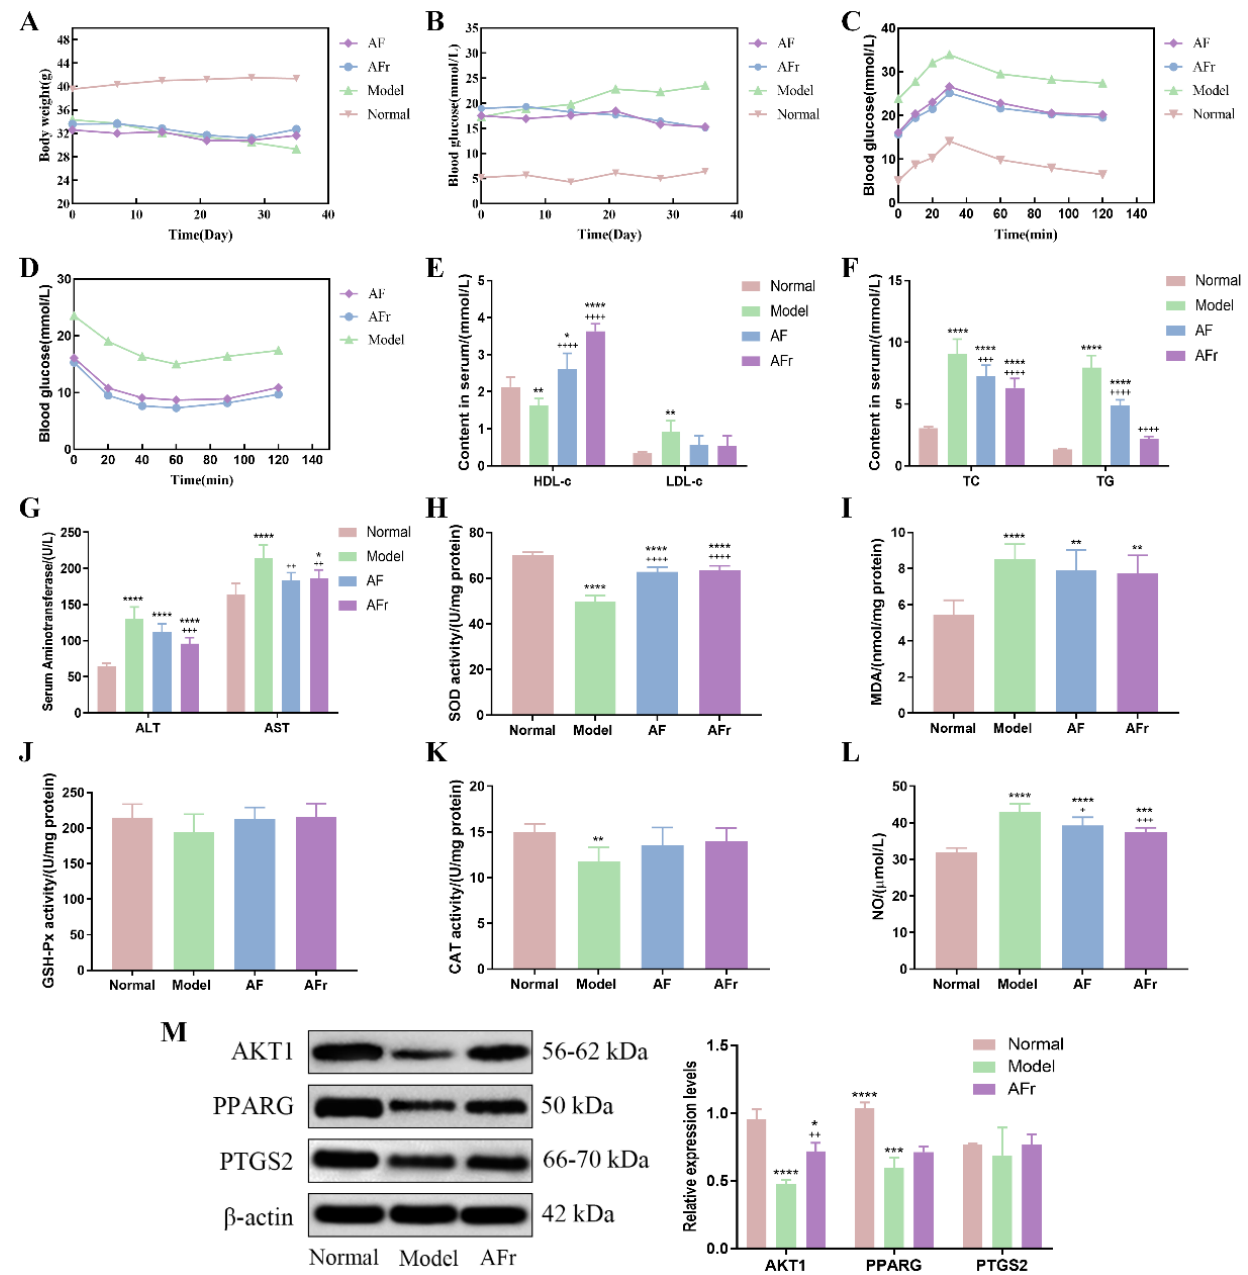
Figure 6. Effects on body weight ( A ), fasting blood glucose (FBG, B ), oral glucose tolerance test (OGTT, C ), insulin tolerance test (ITT, D ), high/low − density lipoprotein cholesterol (HDL − c & LDL − c, E ), total cholesterol & triglyceride (TC &TG, F ), alanine aminotransferase & aspartate aminotransferase (ALT & AST, G ), superoxide dismutase (SOD, H ), malonaldehyde (MDA, I ), glutathione peroxidase (GSH − Px, J ), catalase (CAT, K ), and nitric oxide (NO, L ) (six mice per group). The expression levels of RAC − alpha serine/threonine − protein kinase (AKT1), peroxisome proliferator activated receptor gamma (PPARG), and prostaglandin G/H synthase 2 (PTGS2) proteins in liver tissue ( M ), data were shown as mean ± SD (n = 3). (compared to the normal group, * p < 0.05, ** p < 0.01, *** p < 0.005, **** p < 0.001; compared to the model group, + p < 0.05, ++ p < 0.01, +++ p < 0.005, ++++ p < 0.001).